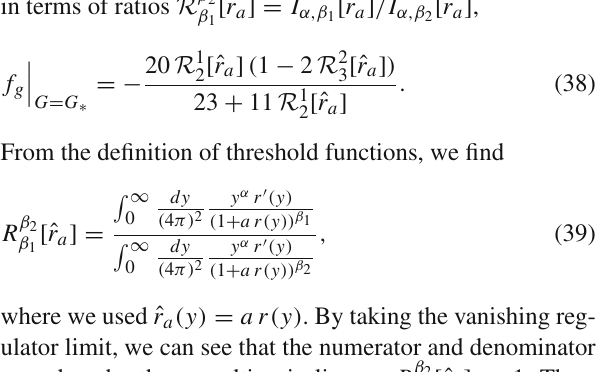
Fig. 1 Left panel: We show the fixed-point value for the Newton coupling, G ∗ , as a function of a for the exponential (red, dashed line) and Litim-type (blue, continuous line) cutoff. Right panel: We show (cid:11) (cid:11) (cid:11) f g , ∗ = f g , which is the G = G ∗ critical exponent at the asymptotically free fixed point for the gauge coupling, as a function of a for the two different shape functions. The result from both shape functions agrees for a → 0 and is